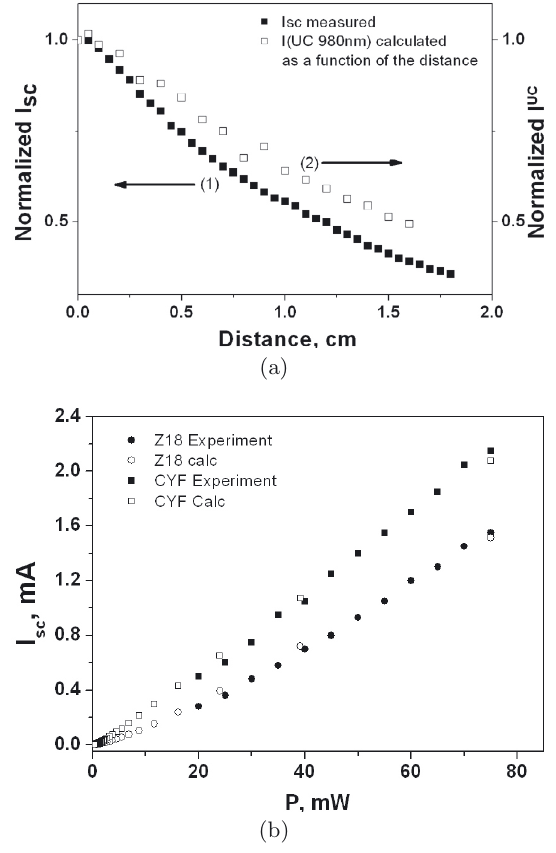
Fig. 8. (a) Comparison between the photocurrent and the in- tensity of the NIR upconverted emission as a function of the distance sample-end fiber laser; (b) comparison between the calculated values of the photocurrent ( I sc ) using equation (A.9) and the experimental data including both experiences ( I sc mea- sured as a function of the excitation power, I sc mesaured as a function of the sample-end fiber distance).